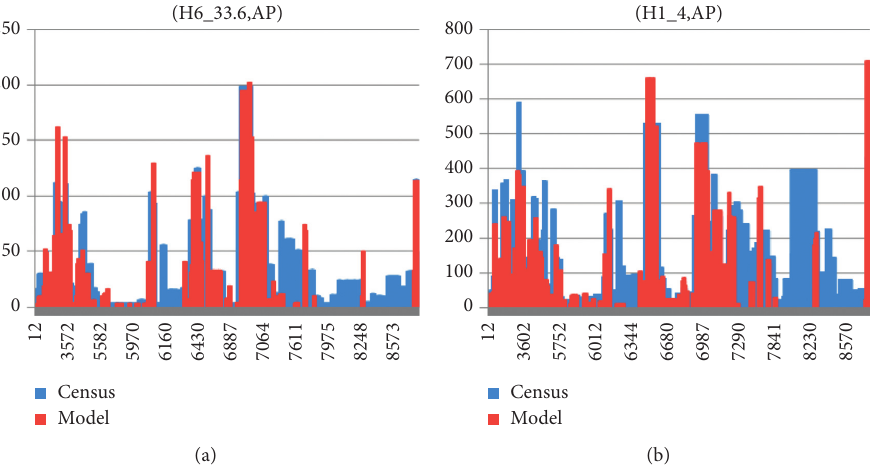
Figure 4: Model accuracy check chart of a different system. (a represents categories 1–4, system and b represents categories 6–3. The abscissa in the figure is the section number and the ordinate is the volume. The blue bar represents the survey data, and the red bar represents the data predicted by the model.)